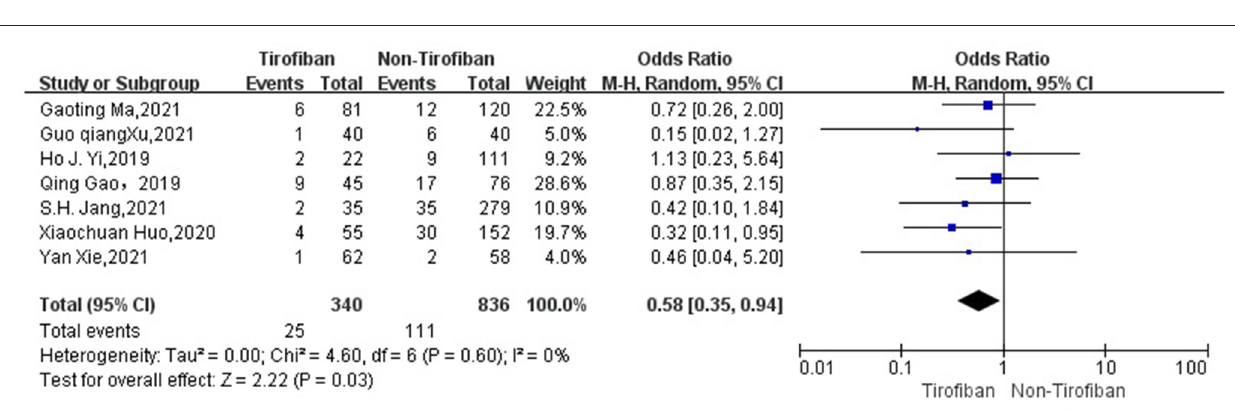
FIGURE 6 | Forest plot and meta-analysis of mortality at 3 months.